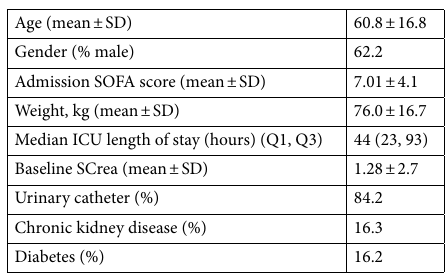
Table 1. Baseline demographic and clinical data.